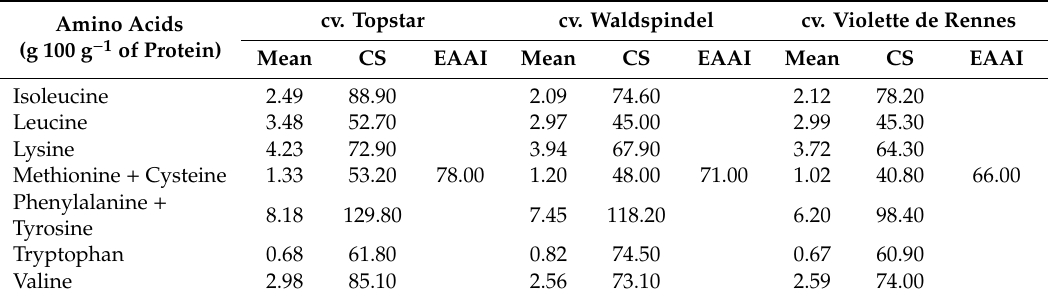
Table 6. Nutritional value of protein in tubers of the analyzed Jerusalem artichoke cultivars. Amino Acids (g 100 g − 1 of Protein)